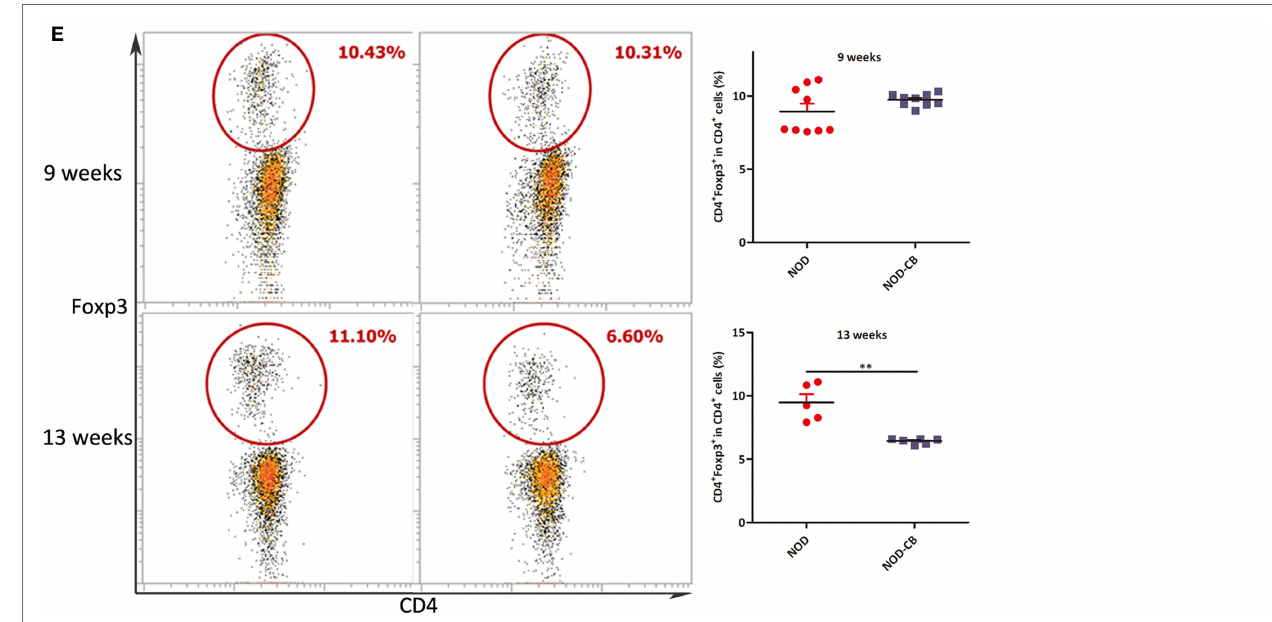
FigUre 5 | CB0313.1 changes cytokine profiles and induces Tregs in the MLN. (a) Percent IFN- γ + in CD4 + cells in MLN as indicated at 13 weeks of age. (B) Percent IL-4 + in CD4 + cells in MLN as indicated at 13 weeks of age, and protein level of IL-4 determined by ELISA at 13 weeks of age. (c) Percent IL-17A + in CD4 + cells in MLN as indicated at 13 weeks of age, and protein level of IL-17A determined by ELISA at 13 weeks of age. (D) Percent Foxp3 + in CD4 + cells, percent CD4 + Foxp3 + in α 4 β 7 + cells in MLN as indicated at 6 weeks of age, and protein levels of TGF- β , IL-10 determined by ELISA at 13 weeks of age. (e) Percent Foxp3 + in CD4 + cells in MLN as indicated at 9, 13 weeks of age. Data are mean ± SEM ( n = 5–9 mice per group). *, **, *** p < 0.05, p < 0.01, p < 0.001 vs NOD control mice by t -test. For (a–c,e) , the number of cells is 5,000; For (D) , the number of cells is